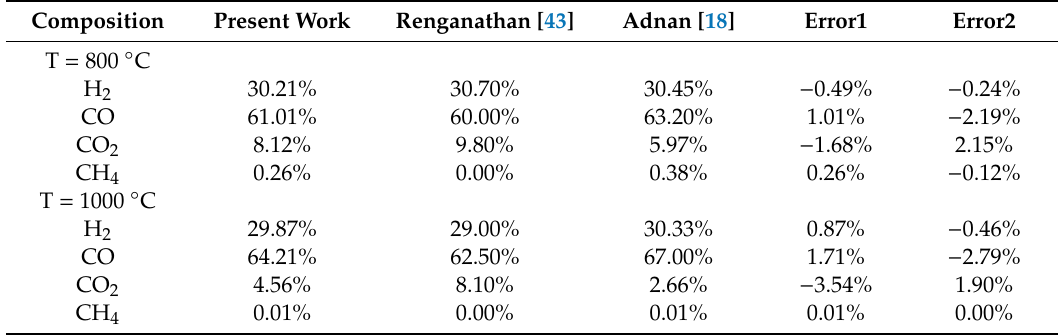
Table 5. Comparison of the producer gas composition simulated by this model and literature